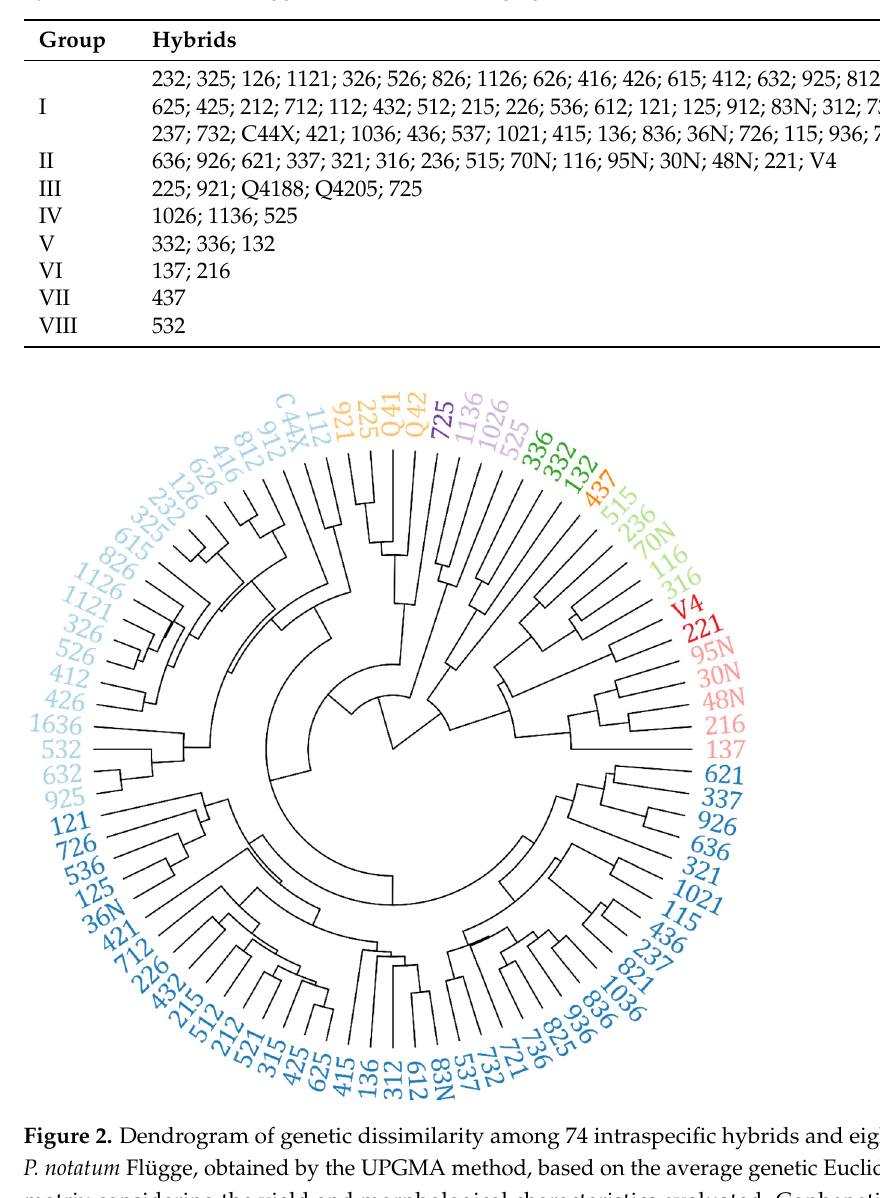
Table 4. Composition of groups formed by the Tocher optimization method for evaluated intraspe- cific hybrids of P. notatum Flügge, based on the average genetic Euclidean distance matrix.